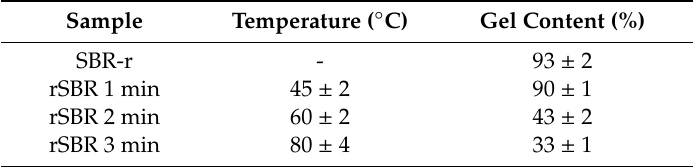
Table 3. Temperature after microwave treatment and gel content of the regenerated styrene-butadiene rubber (rSBR) for different exposure time (1 to 3 min) with a power of 900 W (reproduced with permission from [104]).